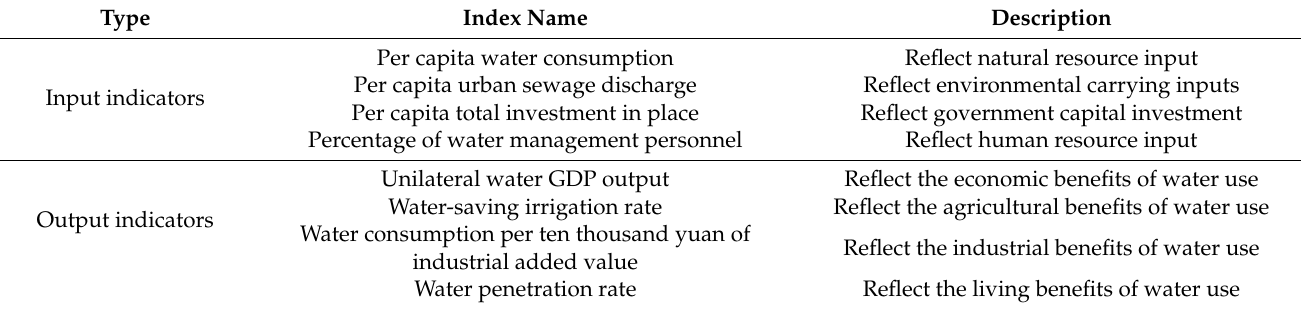
Table 4. Input–output indicator system of the WRM